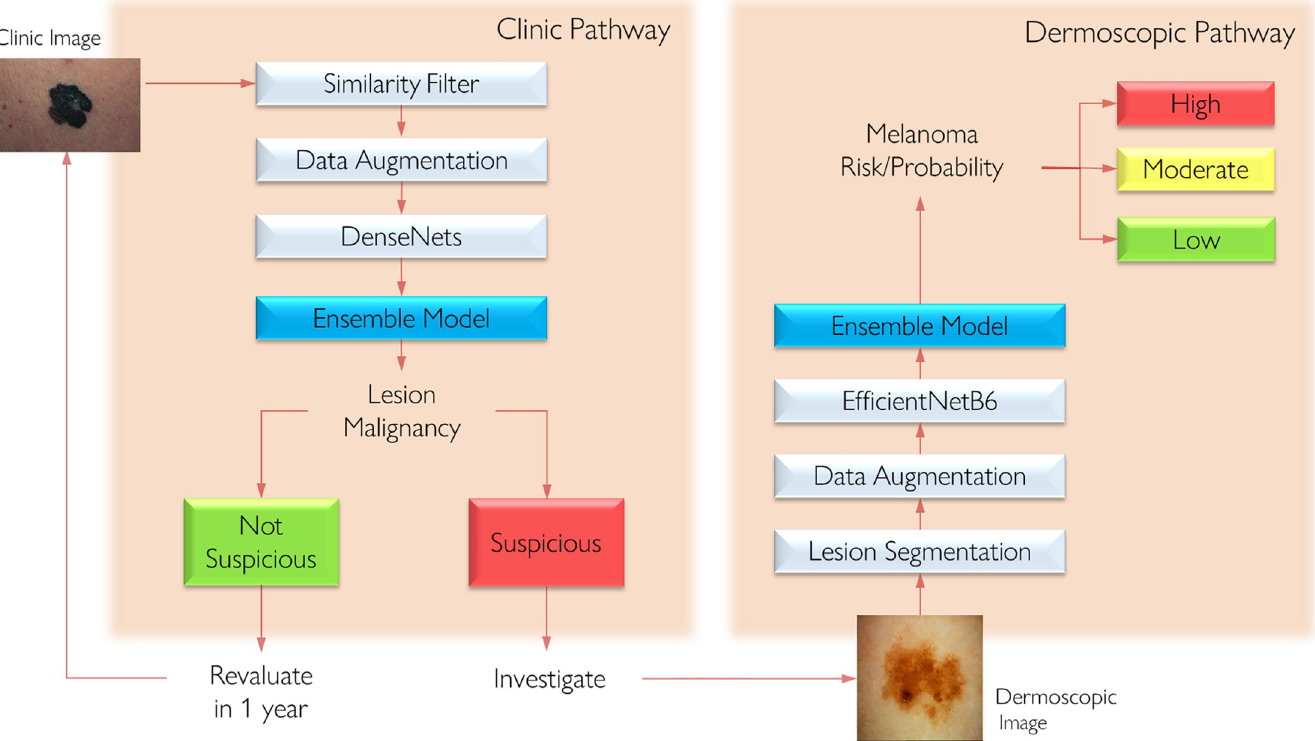
Fig 2. CAD system pathways developed to provide outputs for clinical and dermoscopy images to primary care physicians.